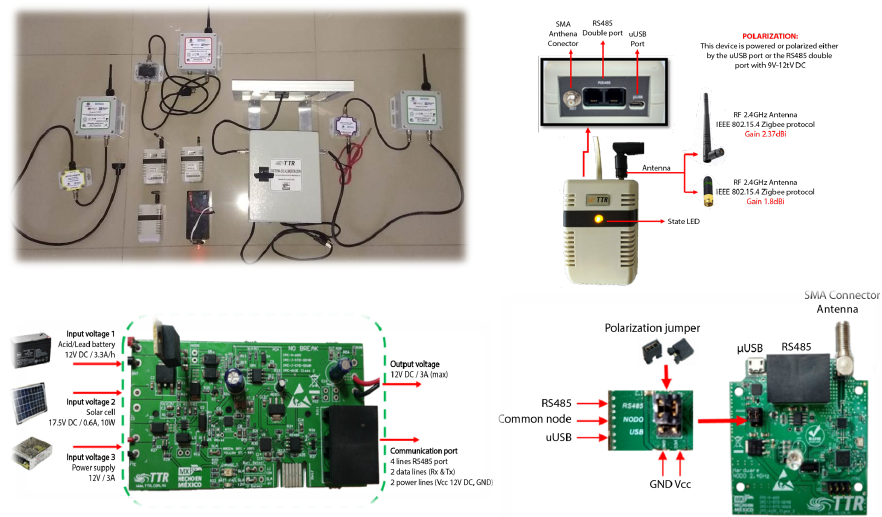
Figure 1. Devices of the network system.